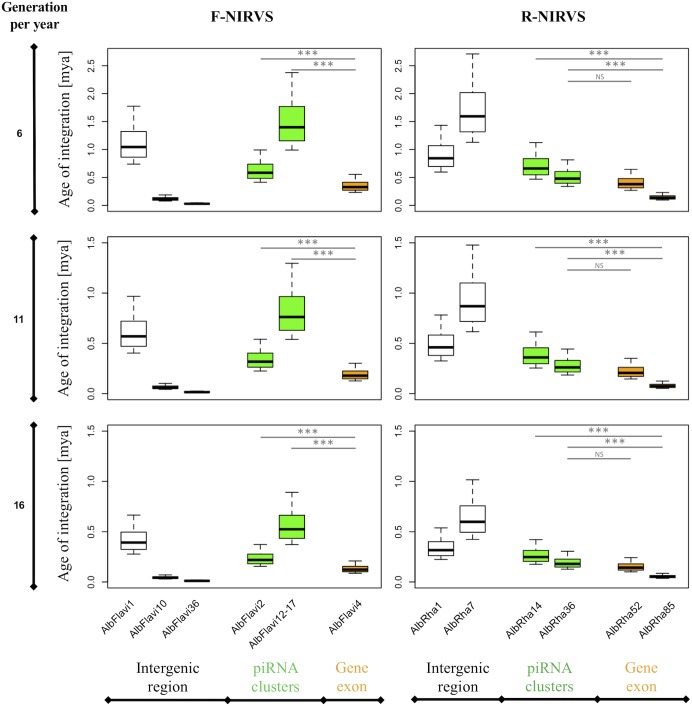
NIRVS integration times. Boxplots showing the integration times for the NIRVS whose variability was studied across five geographic populations. Estimates are based on the D. melanogaster mutation rate, i.e., 3.5–8.4 × 10−9 per site per generation (Haag-Liautard et al., 2007; Keightley et al., 2009), and a range of generations per year between 6 and 16 to include mosquitoes from temperate and tropical regions (Manni et al., 2017). NIRVS of piRNA clusters are statistically older than NIRVS mapping in gene exons (ANOVA, ∗∗∗P < 0.001).